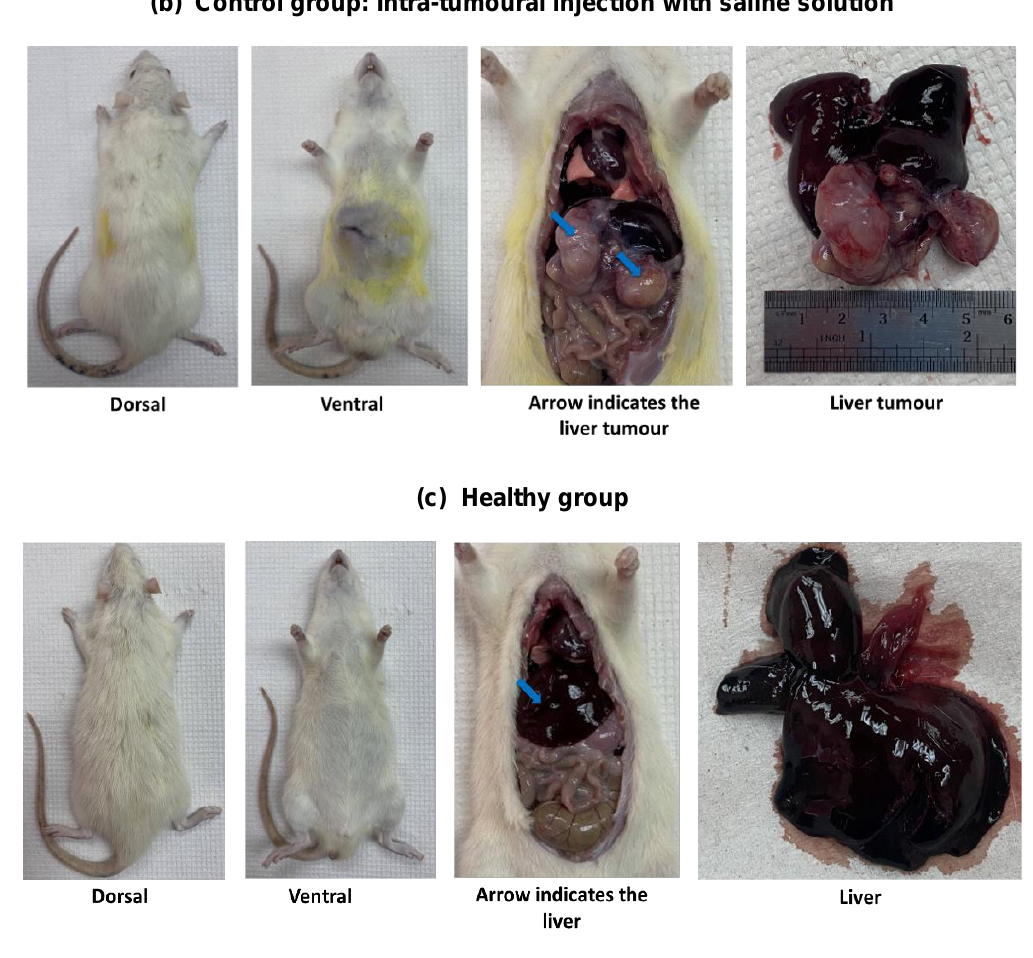
Figure 5. The dorsal view, ventral view, and abdominal organs for each rat in ( a ) study, ( b ) control, and ( c ) healthy groups that were sacrificed at Day 60.